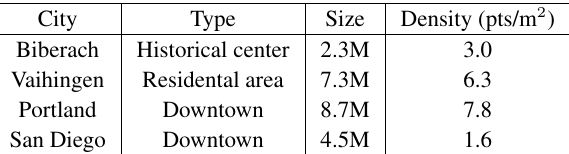
Table 1. Presentation of the dataset.